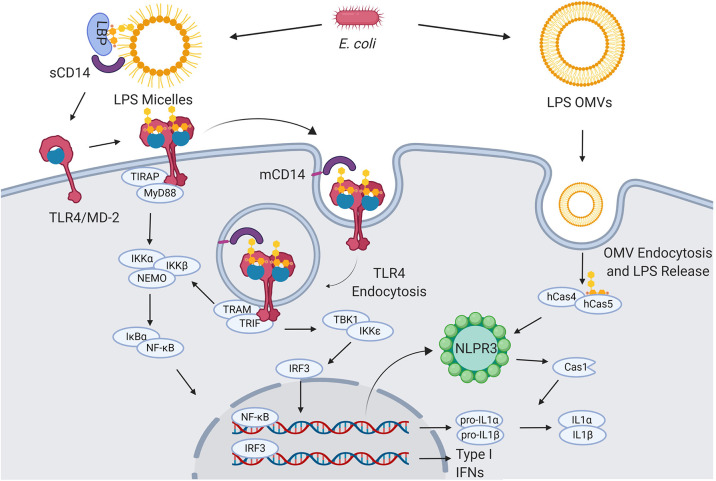
LPS signaling. Extracellular gram-negative bacteria release LPS in the form of micelles or OMVs. OMVs and micelles containing LPS can be delivered intracellularly where LPS activates caspase-dependent responses (right). Soluble LPS-binding protein (LBP) allows CD14 to capture LPS monomers. CD14 increases the sensitivity of TLR4-MD2 for LPS and favors the re-location of the complex formed by LPS, CD14, and TLR4-MD2 in the plasma membrane lipids rafts. Once in the lipid rafts, TLR4-MD2 starts TIRAP-MyD88-dependent responses. CD14 also induces the endocytosis of LPS and TLR4-MD2. From endosomes TLR4-MD2 triggers the TRAM-TRIF pathway and thereby sustains the activation of NF-κB and the production of type I IFNs (5–8).